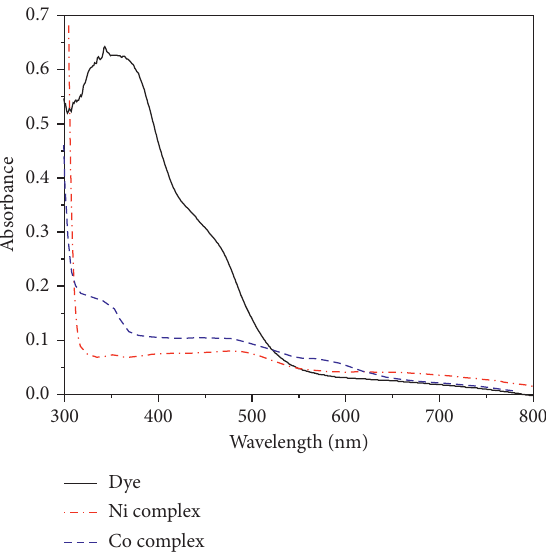
Figure 11: Electronic absorption spectra of CPAT, cobalt, and nickel complexes in DMSO at ambient temperature. Table 1: Inhibition zone (cm) of synthesized compounds against E. coli and Staph. aureus bacteria and Aspergillus fungi . Compound E. coli Staph. aureus Aspergillus CPAT dye